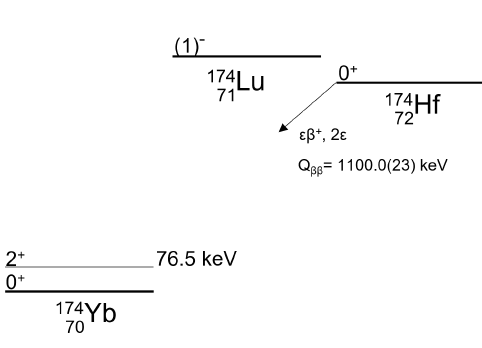
Figure 1. Simplified (cid:101)β + and 2 (cid:101) decay scheme of 174 Hf.